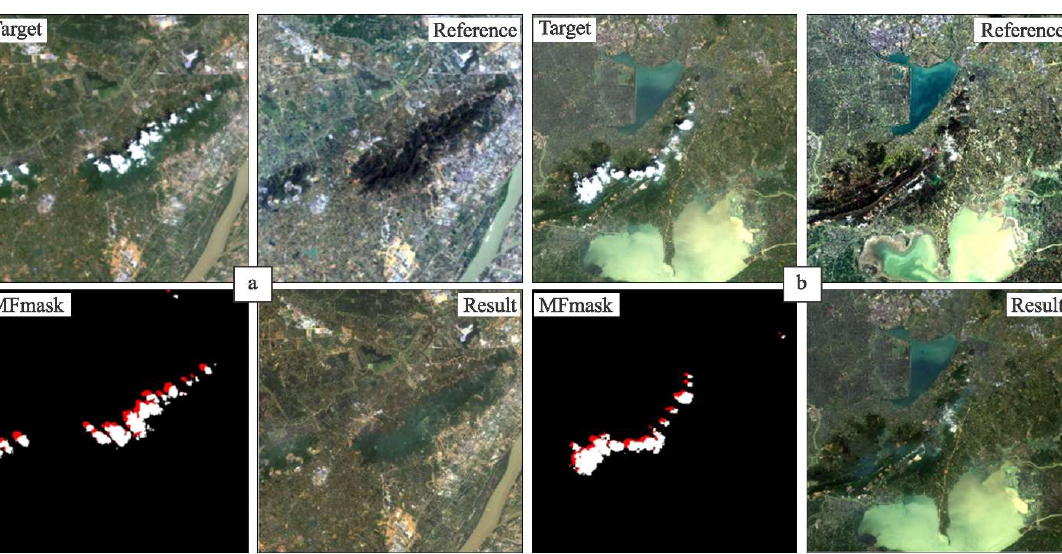
Figure 8. LRM results of small scattered patch from Landsat8 OLI image (p120r38_20160429) located in Southeast China near Nanjing City (1000 × 1000 pixel subset). ( a , b ) are two tests about removal of scattered clouds along with apparent cloud shadows shown in Figure 7a for site A and B (bands 5, 4 and 3 composited). Upper left shows a subset of Landsat8 OLI image with cloud and cloud shadow covered. Upper right represents the corresponding subset of the reference OLI image (p120r38_20160328). Lower right is the corresponding reconstructed result by the proposed LRM algorithm. Lower left refers to the corresponding MFmask results, including clouds (white), cloud shadows (red) and clear sky (black).